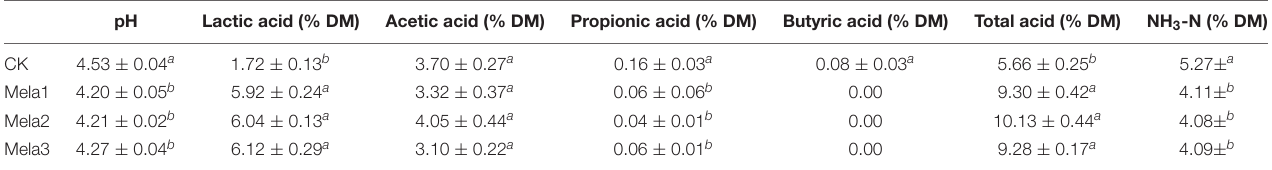
TABLE 1 | Fermentation quality of Stylo silage supplemented with melatonin.